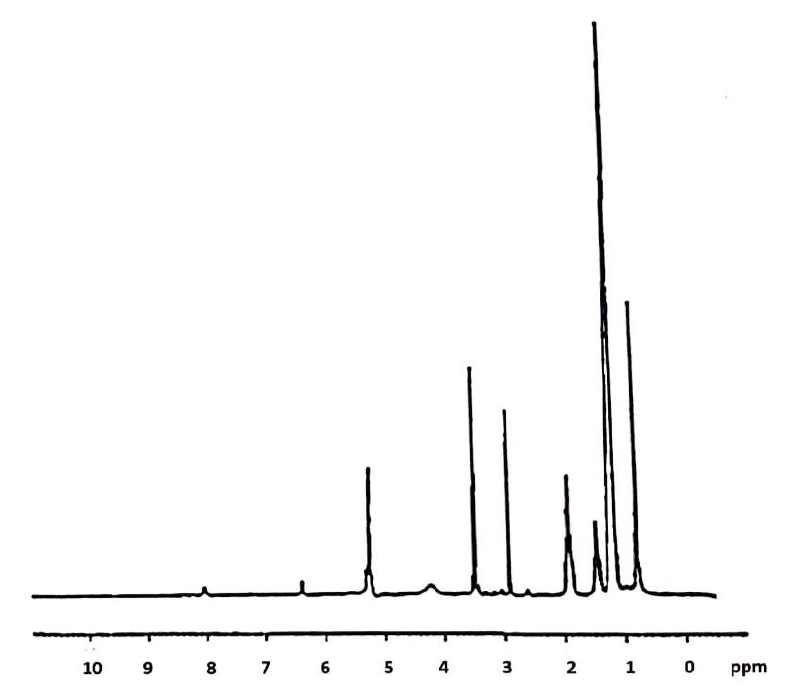
Figure 3. 1 H-NMR spectrum of CsACC.